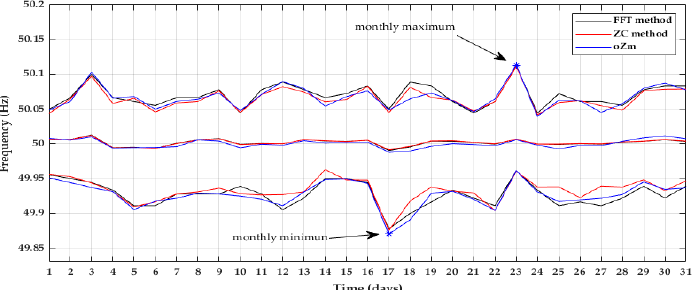
Figure 11. Maximum, minimum, and mean frequency per day. May 2021. Sensors 2022 , 22 , x FOR PEER REVIEW